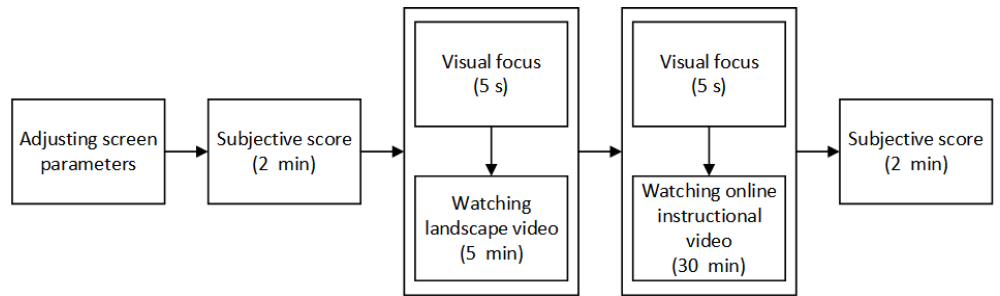
Figure 3. Experimental flow chart.